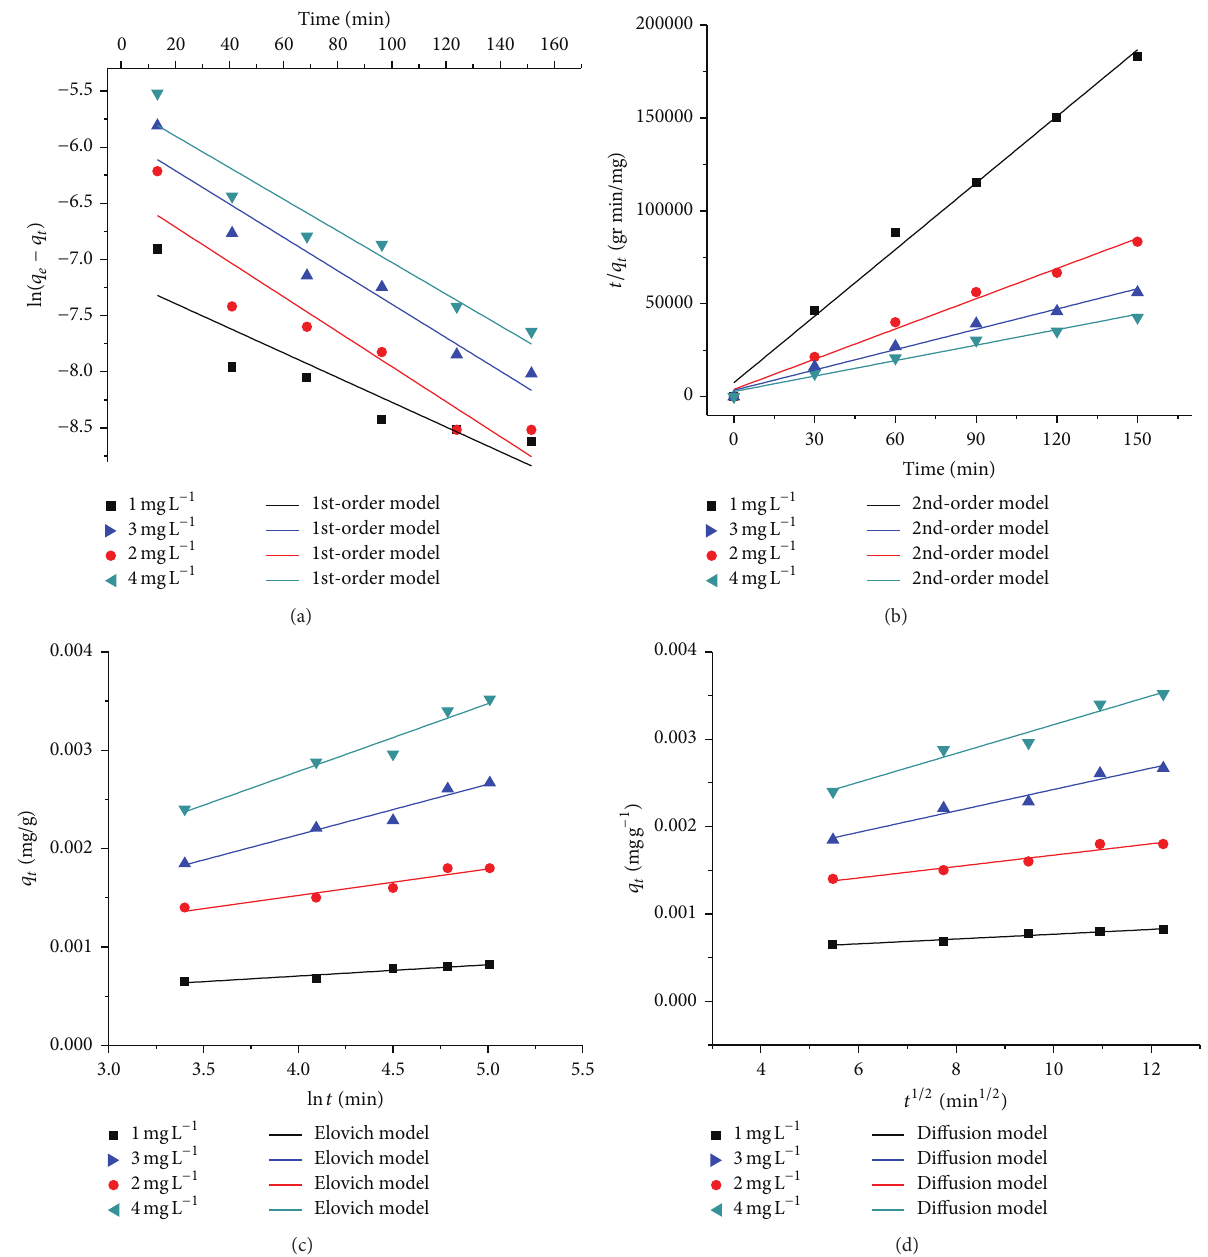
Figure 4: Graphs of the theoretical models corresponding to (a) Lagergren pseudo-first-order model, (b) pseudo-second-order model, (c) Elovich, and (d) intraparticle diffusion